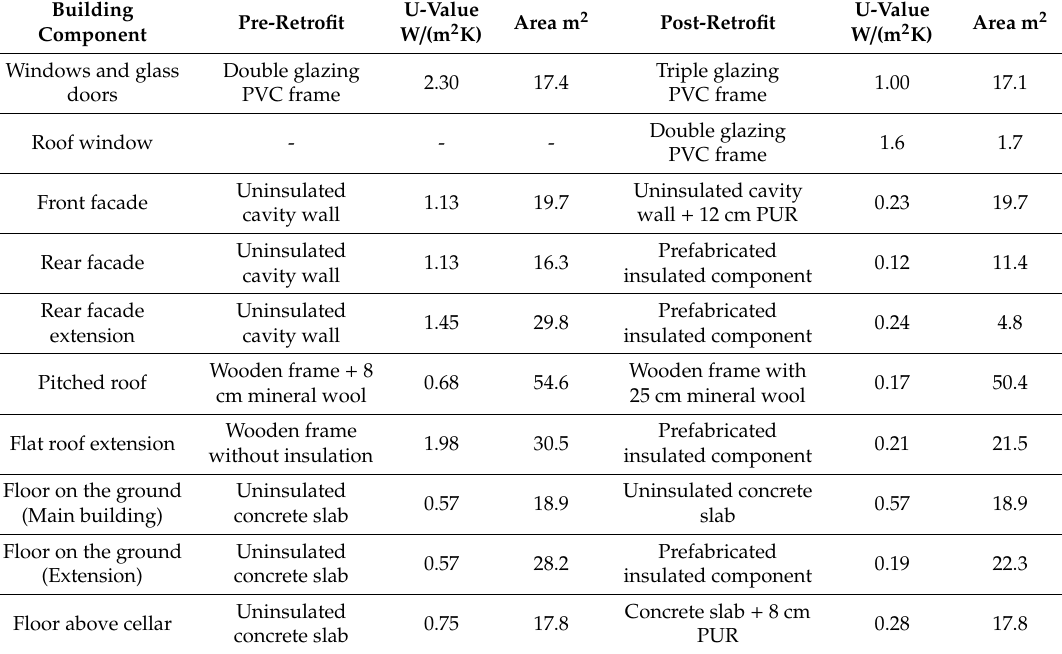
Table 1. Target U-values (W/(m 2 K)) and surface areas (m 2 ) of the pre-retrofit and post-retrofit building envelope.